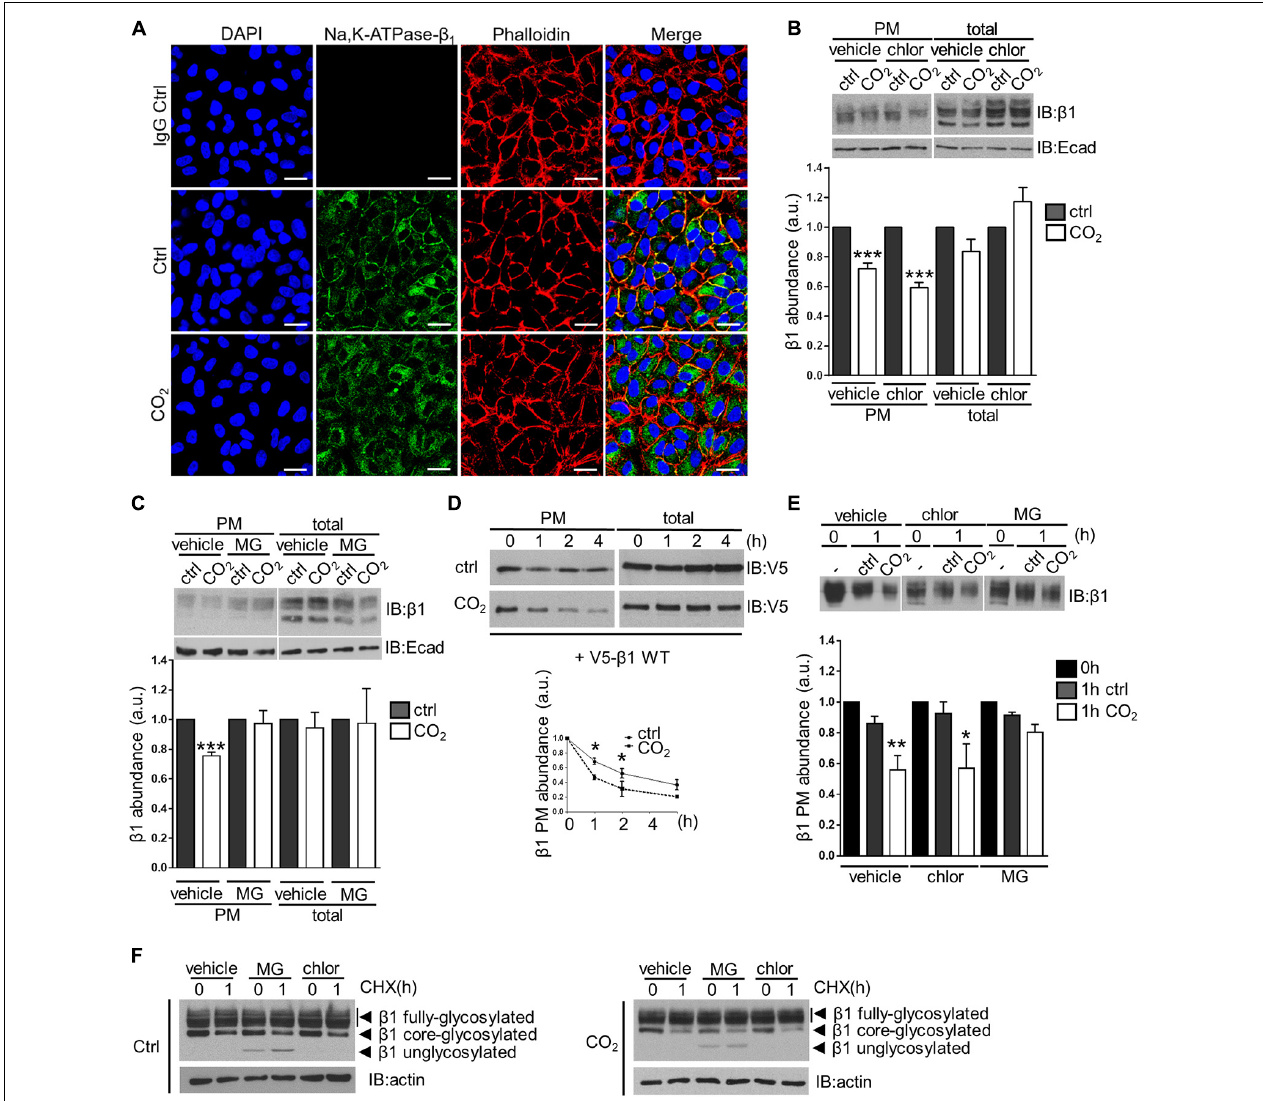
FIGURE 1 | Elevated CO 2 levels induce endocytosis and subsequent degradation of the Na,K-ATPase β -subunit in alveolar epithelial cells. (A) A549 cells were exposed to 40 or 110 mmHg CO 2 at a pH of 7.4 for 30 min. Cellular localization of the Na,K-ATPase β -subunit was detected by confocal microscopy using an anti-Na,K-ATPase β 1-subunit antibody (green) under normocapnia (Ctrl) or hypercapnia (CO 2 ) and in the absence of the specific antibody (IgG Ctrl). Additional phalloidin (red) and nuclei (blue) staining are shown. Scale bar = 20 µ M. (B) A549 cells were exposed to 40 or 110 mmHg CO 2 at a pH of 7.4 for 30 min in the presence of vehicle (water) or chloroquine (100 µ M). Na,K-ATPase β -subunit at the surface was determined by biotin-streptavidin pull-down and IB. Total protein abundance is also shown. Mean ± SEM, n = 3, paired t -test, *** p < 0.0005. (C) A549 cells were exposed to 40 or 110 mmHg CO 2 at a pH of 7.4 for 30 min in the presence of vehicle (DMSO) or MG-132 (20 µ M). Na,K-ATPase β -subunit at the surface was determined by biotin-streptavidin pull-down and IB. Total protein abundance is also shown. Mean ± SEM, n = 3, paired t -test, *** p < 0.0005. (D) A549 cells were transfected with V5- β 1 wt and surface proteins were labeled with biotin and chased in 40 or 110 mmHg CO 2 at a pH of 7.4 for different time points. Afterward, streptavidin pull-down was performed and Na,K-ATPase β -subunit abundance was analyzed by IB. Mean ± SEM, n = 3, paired t -test, * p < 0.05. (E) Surface proteins of A549 cells were labeled with biotin and chased in 40 or 110 mmHg CO 2 at a pH of 7.4 for 1 h in the presence of vehicle (DMSO), chloroquine (100 µ M), MG-132 (20 µ M). Afterward, streptavidin pull-down was performed and Na,K-ATPase β -subunit abundance was analyzed by IB. Mean ± SEM, n = 3, paired t -test, * p < 0.05. (F) A549 cells were exposed to 110 mmHg CO 2 at a pH of 7.4 for 1 h with CHX (1.7 mM) in the presence of vehicle (DMSO), chloroquine (100 µ M), MG-132 (20 µ M). Total Na,K-ATPase β -subunit abundance was determined by